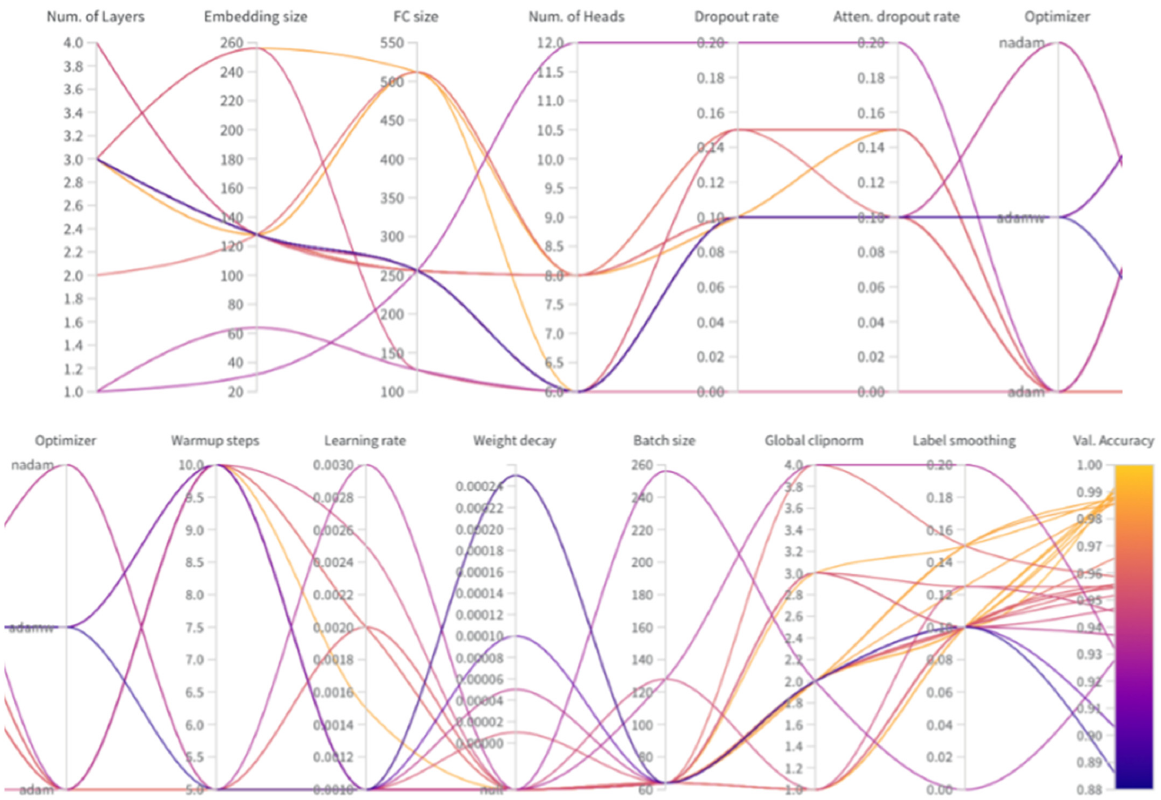
Figure 4. Parallel coordinates chart, split in half into two rows. The combinations of hyperparameter values plotted on multiple y-axes is shown in the Figure 4. The last part of the chart consists of a color scale, with light yellow color presenting the highest accuracy and dark blue color the lowest accuracy. From the graph, it is possible to deduce the most suitable intervals of values of hyperparameters, and thus, guide the search for the most advantageous combinations. This technique is advantageous for a guided random search used in this study when one can choose from many possible combinations generated from predefined distributions [52]. Such tuning of hyperparam- eters has an advantage both over the Bayesian hyperparameter optimization as well as over the grid search, in this study, for these methods there are too many hyperparameters to tune optimally. 3. Results In the testing phase, previously unseen examples from test datasets were presented to the neural network. The task was to predict activities from hitherto unseen signals with the highest possible accuracy. Figure 5 shows the individual attention matrices from Head 1 of the transformer model expressing only one activity.